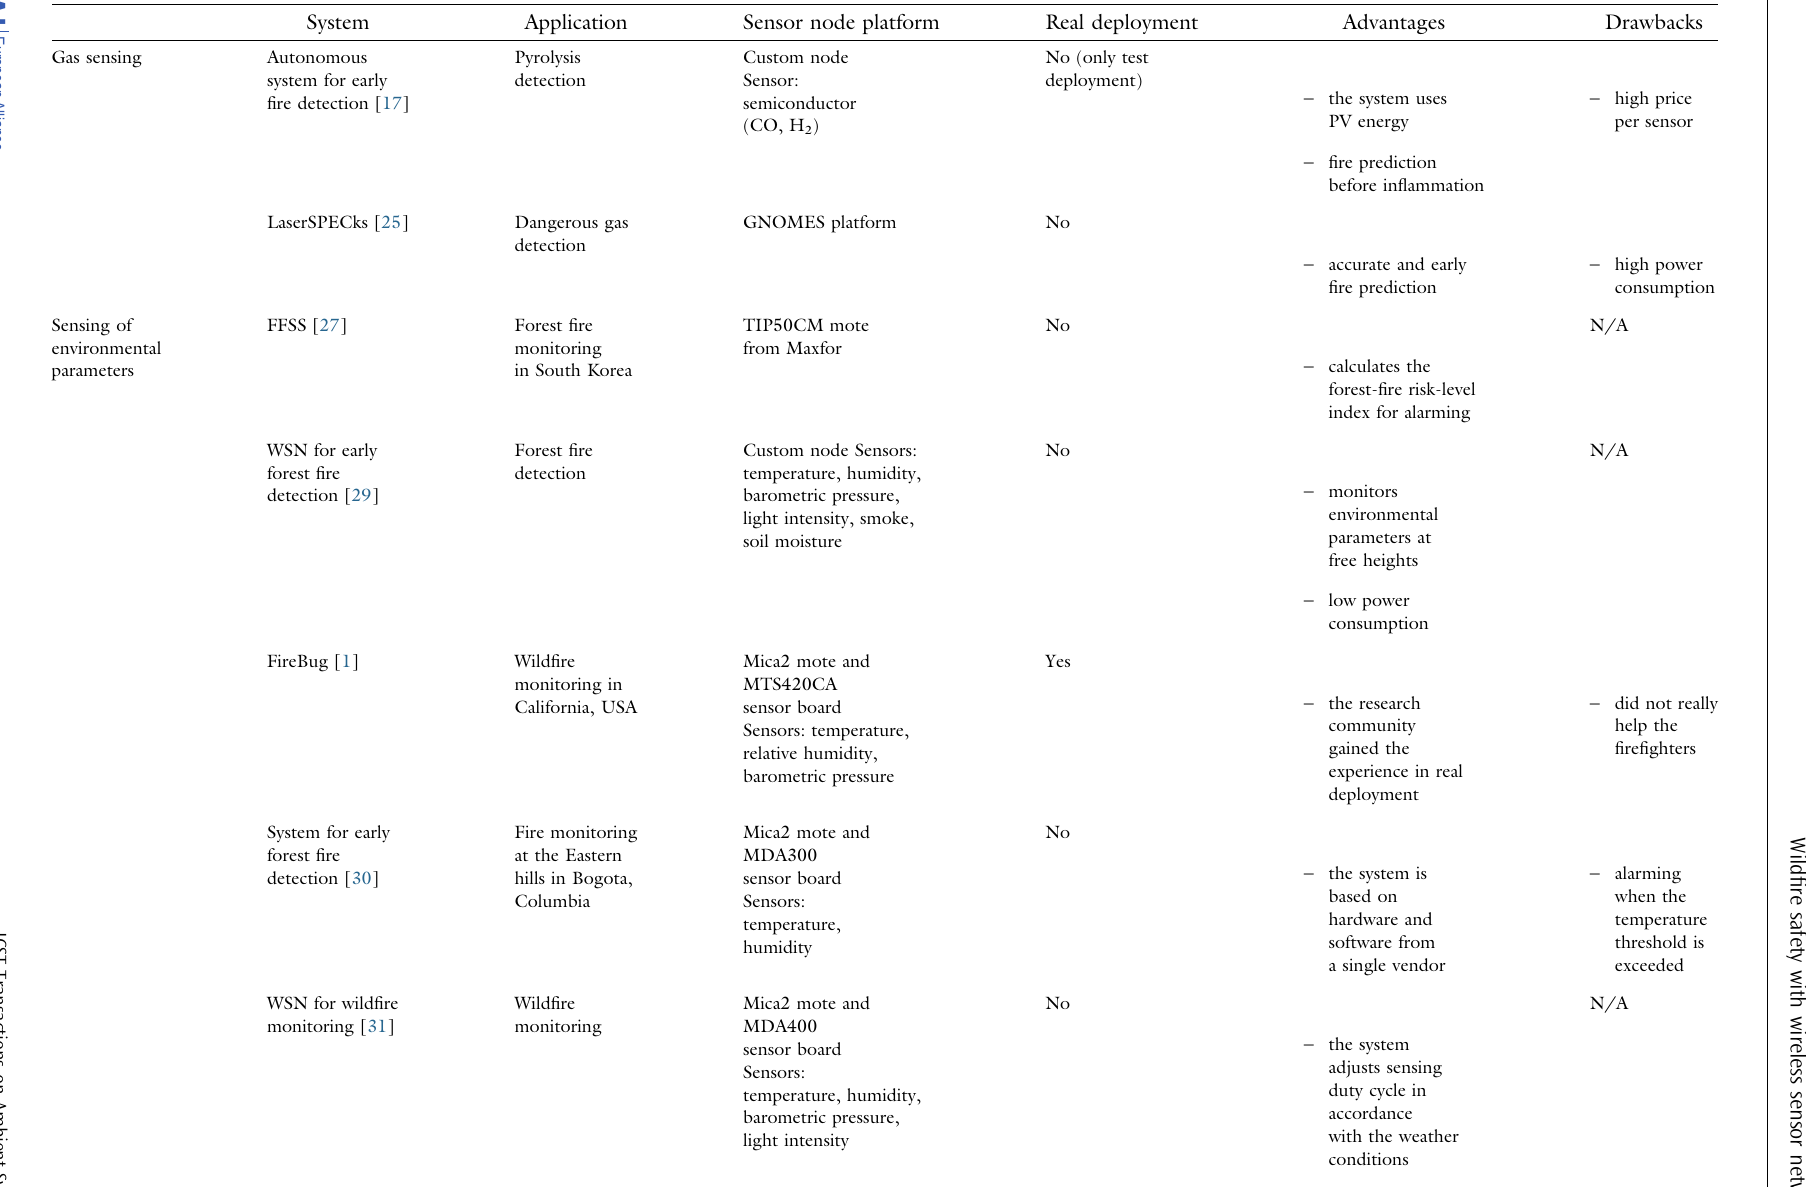
Table 3. WSN platforms for wildfire